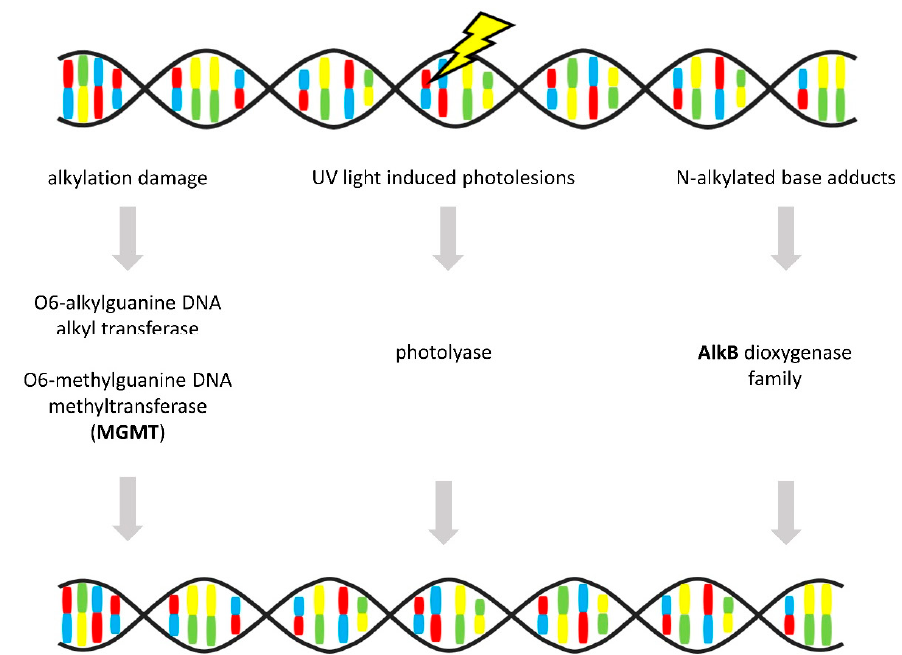
Figure 7. Direct repair. Simplified scheme of direct lesion reversal removing alkylation and UV-induced damage, and N-alkylated base adducts (gene alternations in OvC in bold ) [162]. Protein names: O 6 -methylguanine DNA methyltransferase (MGMT), alpha-ketoglutarate-dependent dioxygenase AlkB (AlkB) [44].